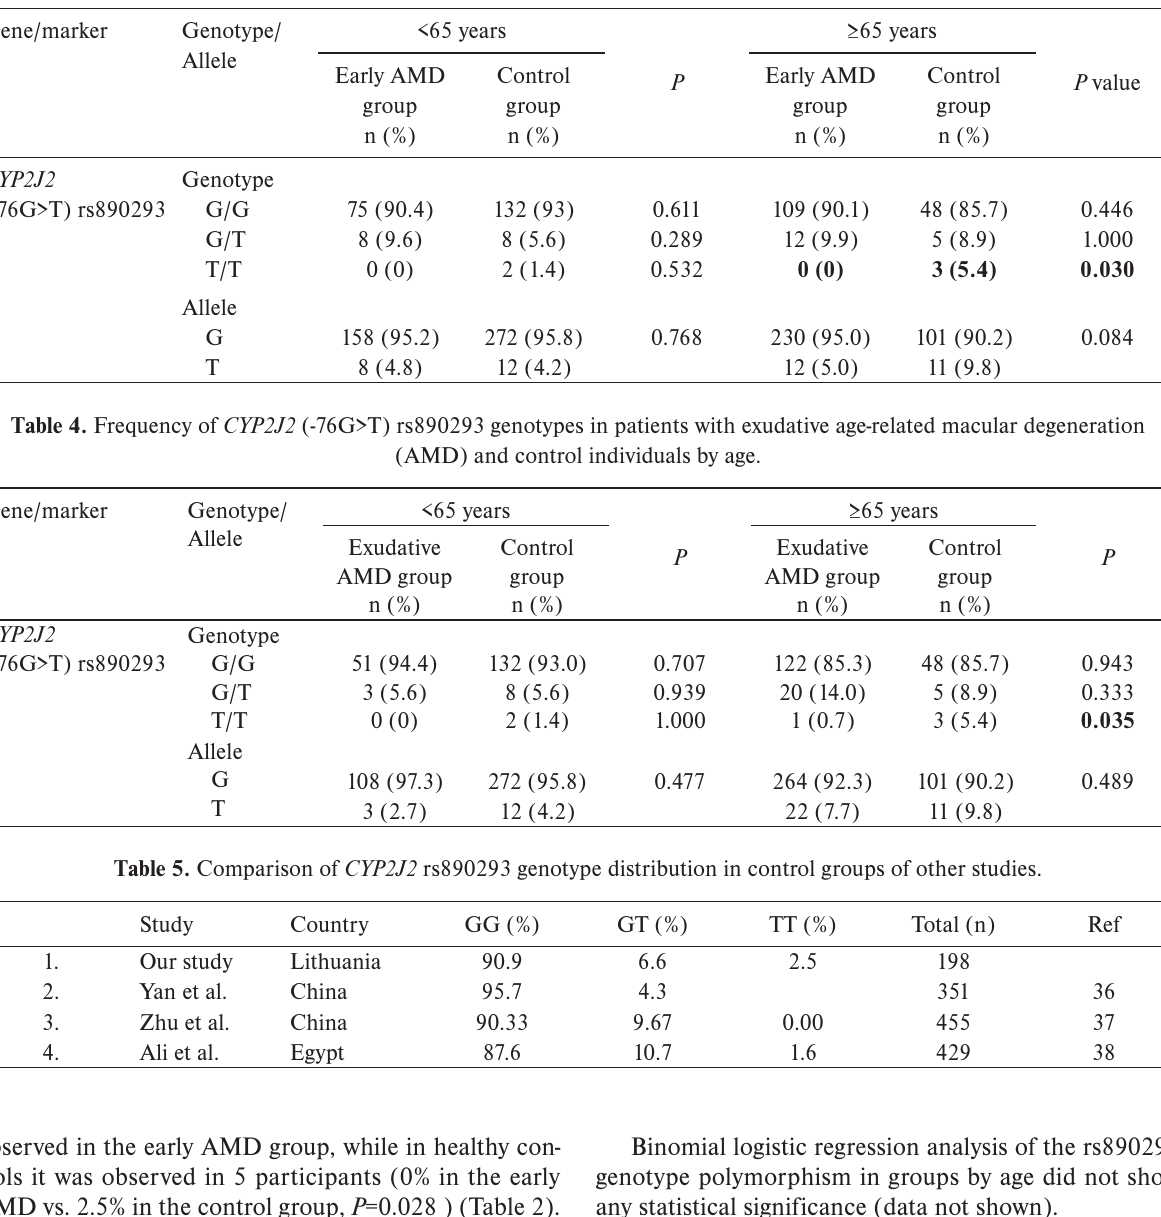
Table 3. Frequency of CYP2J2 (-76G>T) rs890293 genotypes in patients with early age-related macular degeneration (AMD) and control individuals by age.